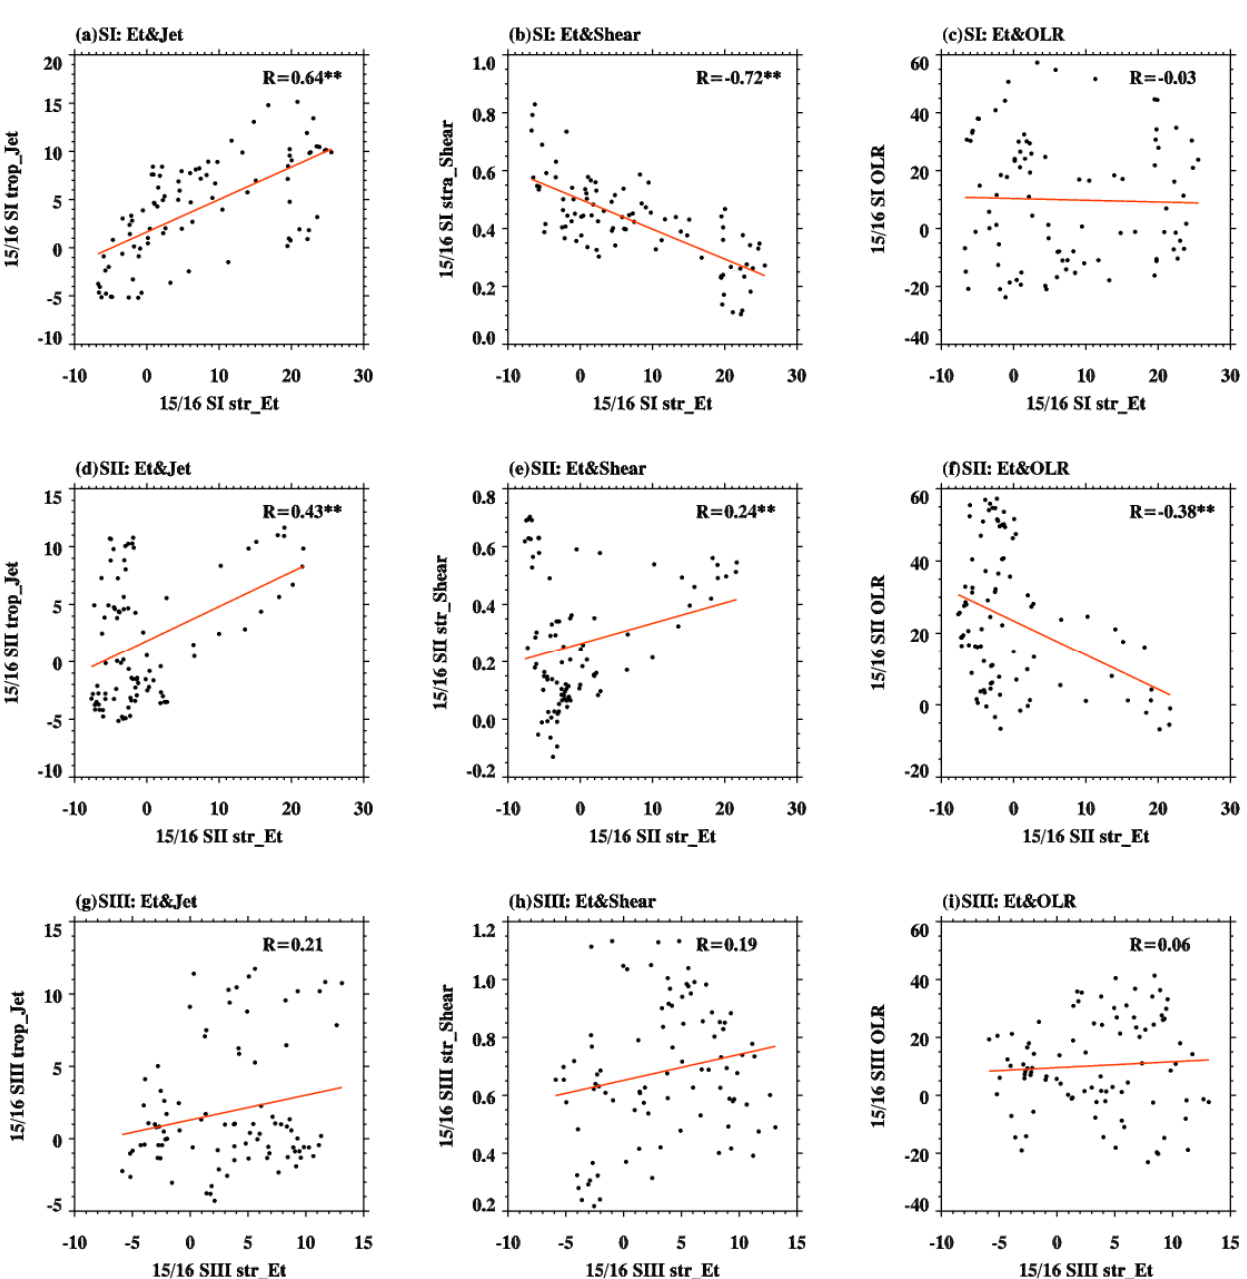
Figure 5. Panels ( a , d , g ) display the scatterplots between tropospheric jet anomaly and the strato- spheric GW total energy density anomaly in SI, SII, and SIII stages in the 2015/2016 event, respectively. Panels ( b , e , h ) are similar to the panels ( a , d , g ) but instead display the scatterplots between strato- spheric vertical shear anomaly and stratospheric GW total energy density anomaly in SI, SII, and SIII stages in 2015/2016, respectively. Panels ( c , f , i ) are similar to above panels but instead display the scat- terplots between detrended OLR and stratospheric GW total energy density anomaly in SI, SII, and SIII in the 2015/2016 event, respectively. The lines denote the fit lines. The correlation coefficients between each factor and the stratospheric GW total energy density anomaly are displayed in the upper right corner of each panel. The double asterisk (“**”) denotes a significant level larger than